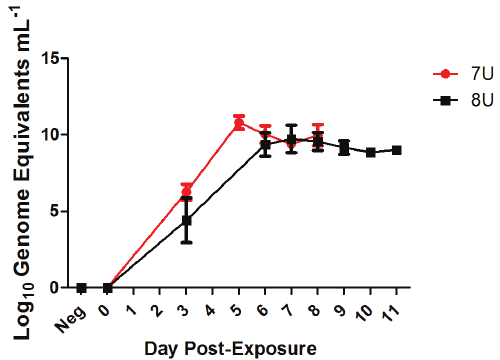
Figure 6. Circulating viral genome equivalents per mL of plasma. Average concentration of circulating viral genome equivalents per mL of plasma across both challenge groups for the naïve NHPs (7U, n = 14, red ; 8U, n = 14, black ). Error bars represent standard deviation.